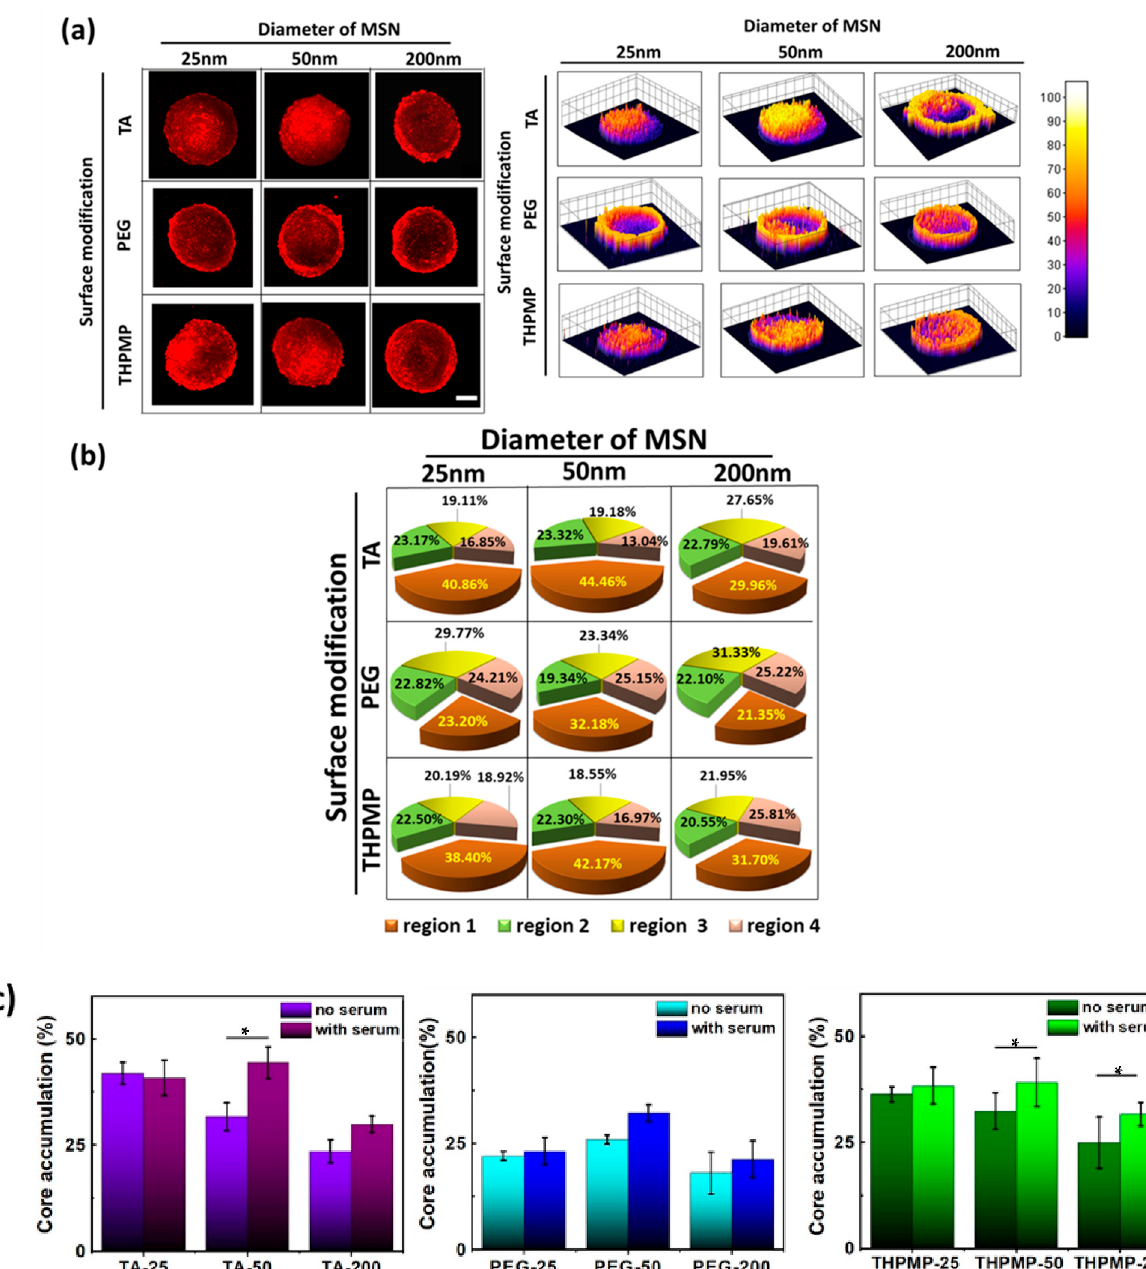
Figure 5. Penetration and distribution of MSNs in spheroids in the presence of serum. ( a ) Two-photon images of MSNs in spheroids and their distribution (z = 160 µm). Scale bars = 100 µm. ( b ) Accumulation of MSNs in different spheroid’s regions. N = 4. ( c ) comparison of the accumulation percentage of MSNs in the spheroid’s core with or without serum (* p -value < 0.05).